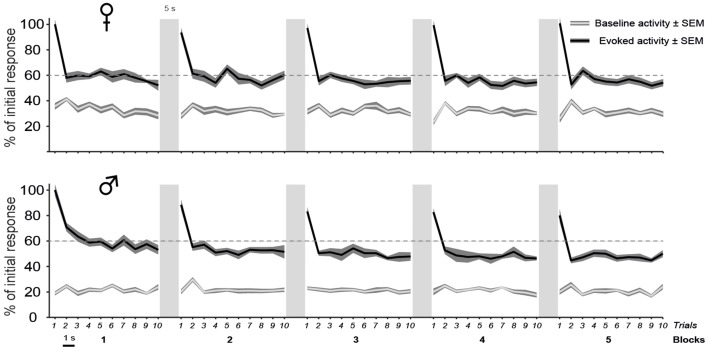
The decline of auditory responses with call repetition is more pronounced in males than in females. A iteration-by-iteration time course of spontaneous activity (gray lines) and responses (black lines) shown for females (top) and males (bottom). Both baseline levels and responses are expressed as a percentage of the call-evoked firing rate in Iteration 1 and are averaged over all call stimuli. The baseline firing rate remains stable over time. Call stimuli are presented as five blocks of 10 consecutive repetitions with a 1 s silence between two iterations and a 5 s silence between two blocks. Each call presentation induces an increase in activity over the spontaneous level (p < 0.05 in all cases). Within a block, the first call presentation evoked responses of a higher magnitude than subsequent presentations (p < 0.05). In males, Blocks 1 and 2 induce responses of a higher magnitude than blocks 3, 4, and 5 (p < 0.05 in all cases) and block 5 (p < 0.05), respectively.